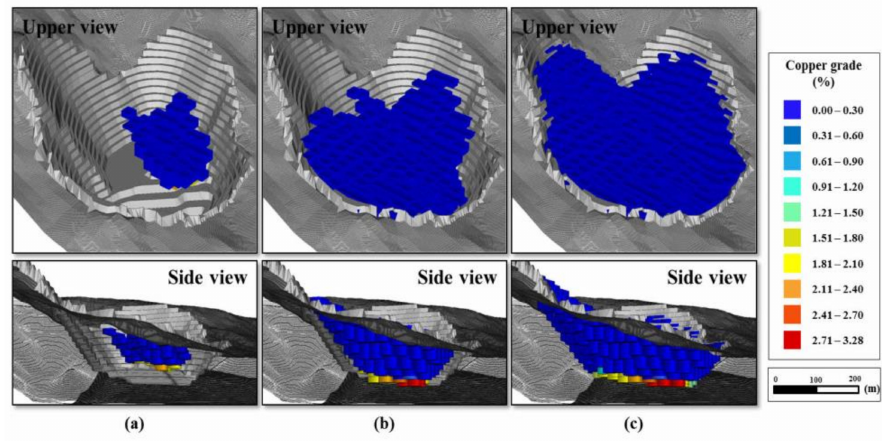
Figure 5. Blocks representing ore reserves above the optimal pit boundary. ( a ) Case 1: probability ≥ 90%. ( b ) Case 1: probability ≥ 80%. ( c ) Case 1: probability ≥ 70%